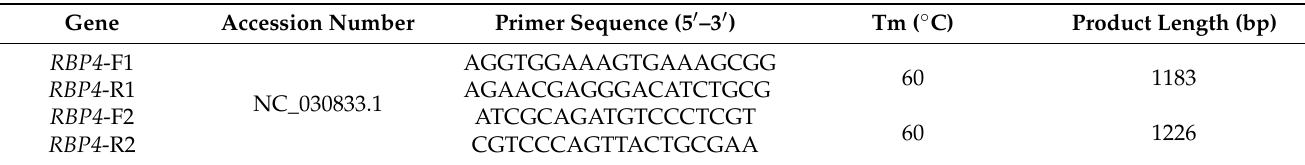
Table 1. Primers for the RBP4 promoter